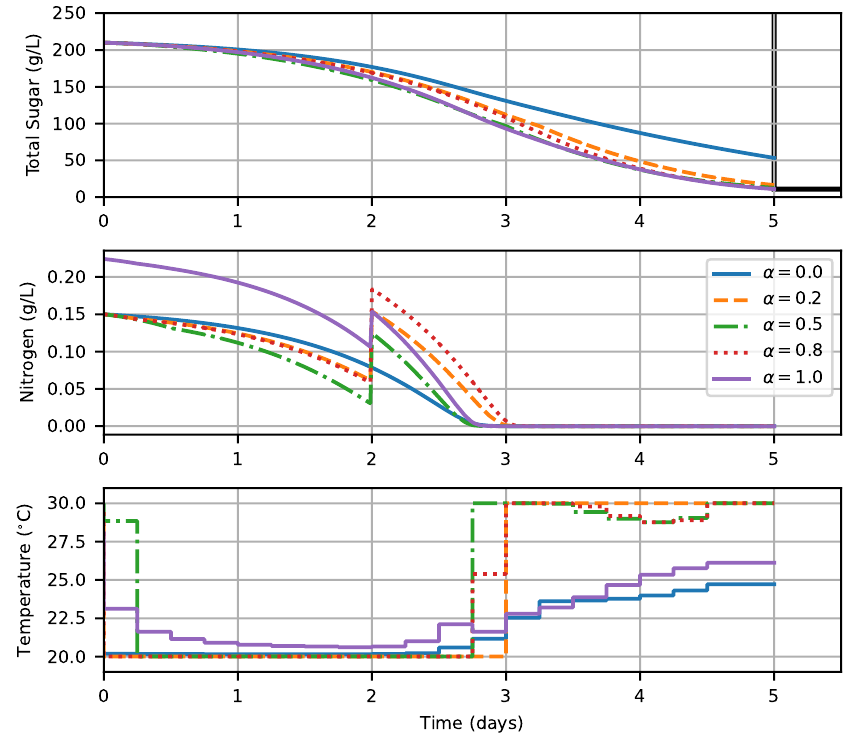
Figure 4. Optimal control simulations for traditional nutrition. Black line in total sugar graph corresponds to the desired digging-out point.